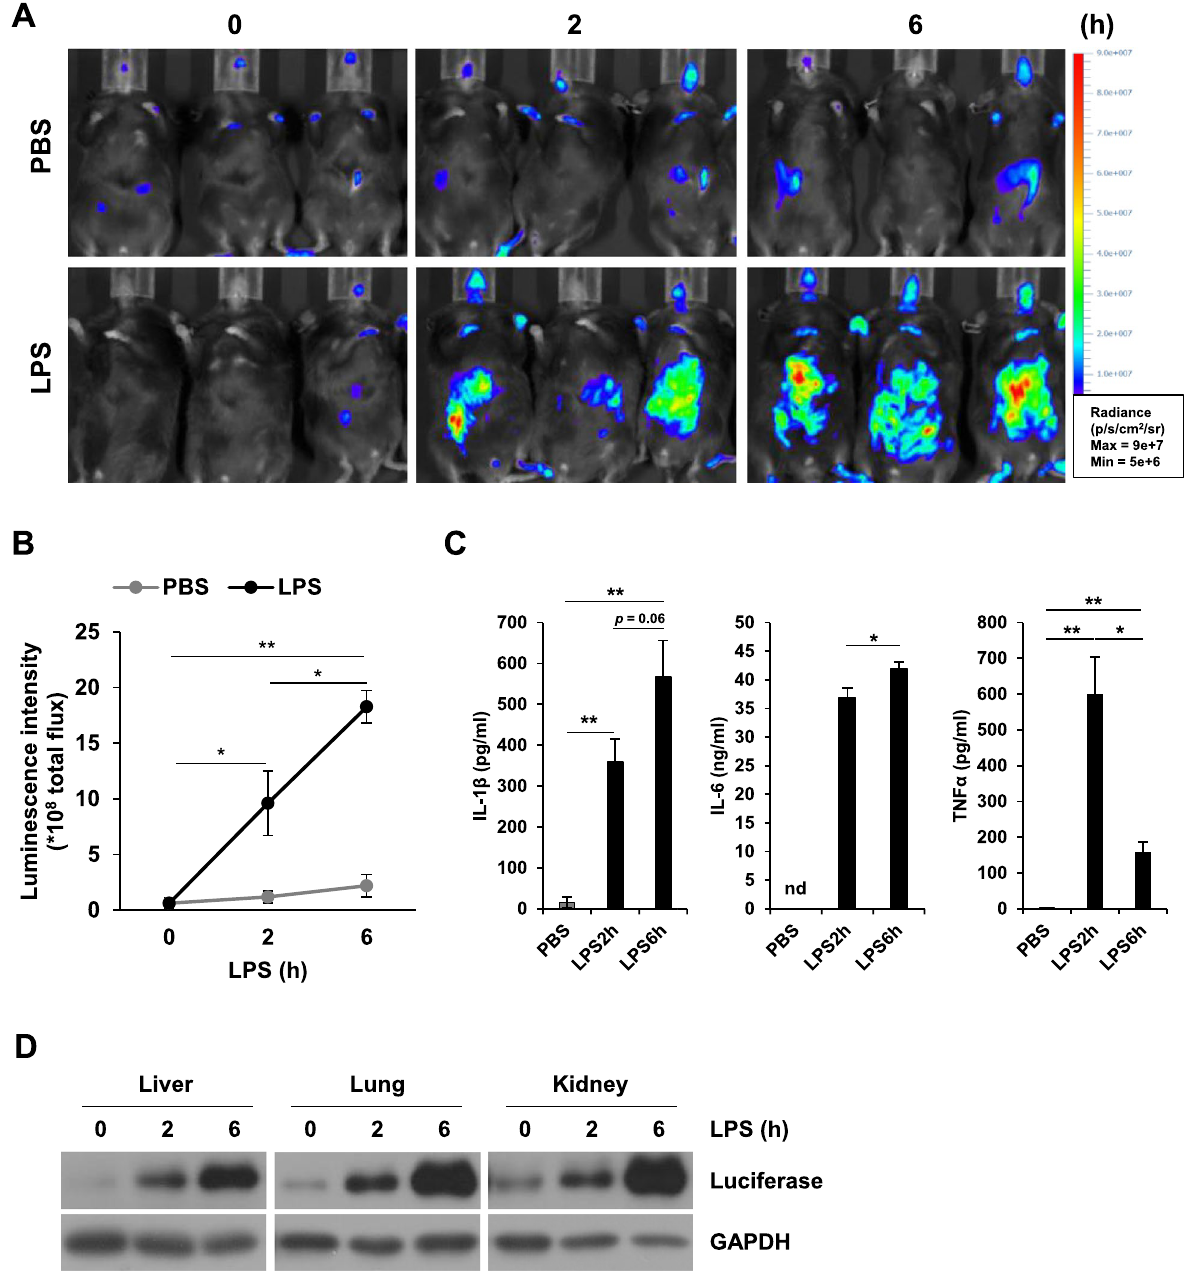
Figure 2. LPS-induced systemic inflammation applied to NF-κB-Luc mice. ( A , B ) Bioluminescence images of PBS or LPS injected NF-κB-Luc mice ( A ) and total abdominal luminescence fluxes ( B ). The images were obtained at different times from each group (n = 3) using VISQUE InVivo ART100. Radiance ranges are provided in the figure. ( C ) Serum levels of IL-1β, IL-6, and TNFα. Results are presented as means ± SEMs (n = 3). * p < 0.05, ** p < 0.01, nd not detected. ( D ) Representative expressions of luciferase in liver, lung, and kidney as determined by western blotting. All western blot images were cropped from the original films presented in Supplementary